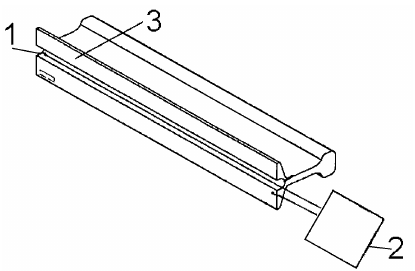
Figure 10. Diagram of rail heating featuring a duct in the rail foot; 1: inductor, 2: power supply and control system, and 3: rail foot [16].